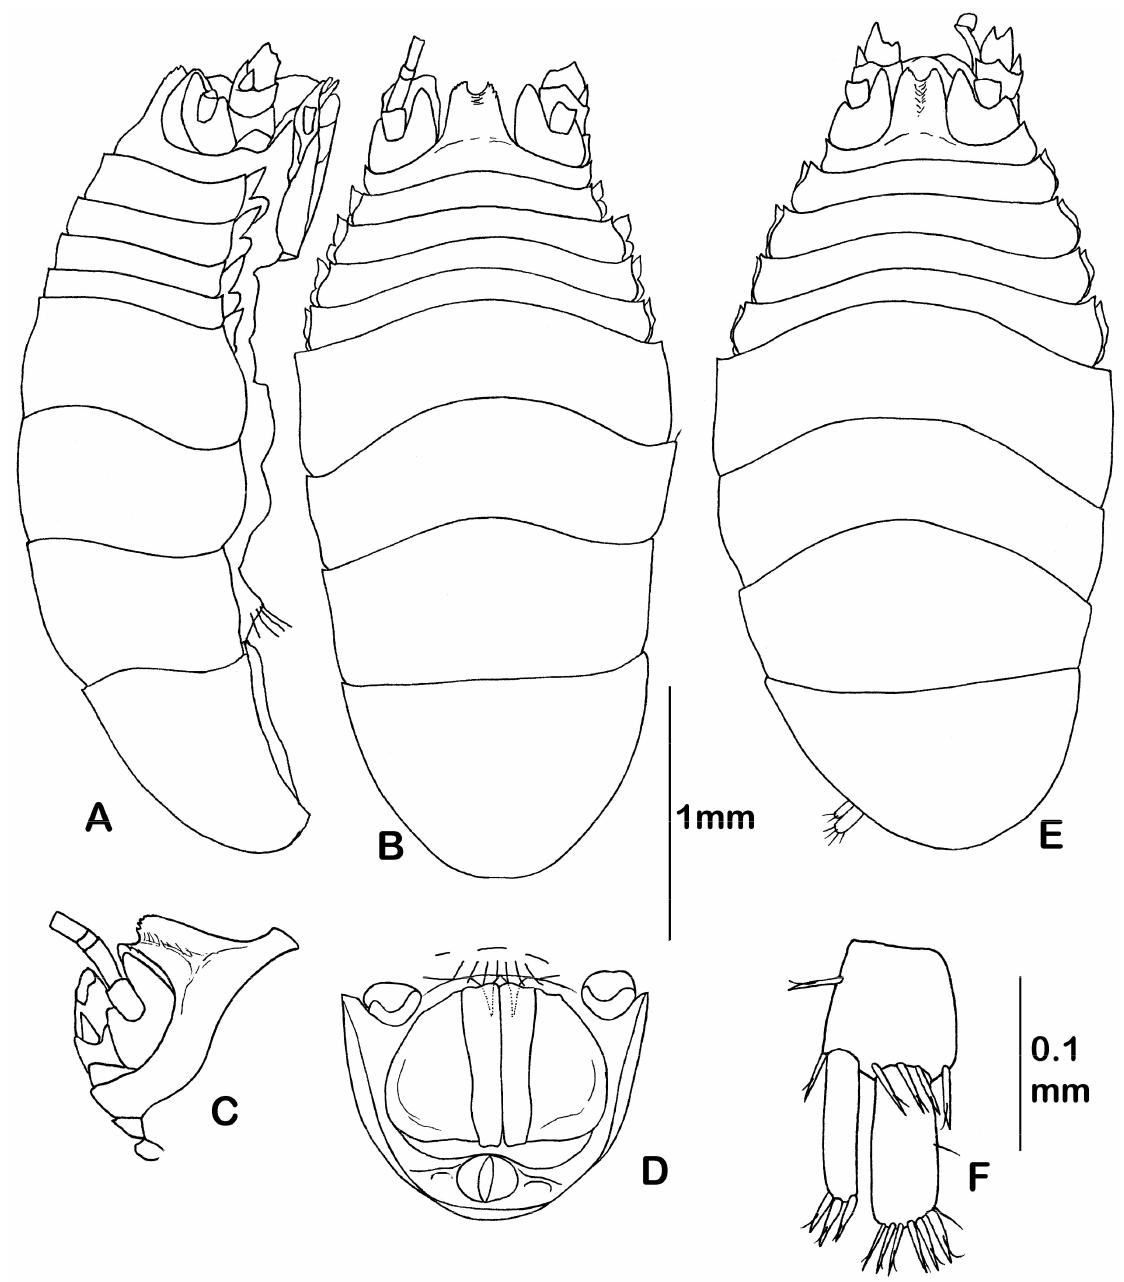
Figure 14. Eurycope mishkai sp. nov. Male holotype (ZMH K-45621): ( A ) lateral view; ( B ) dorsal view; ( C ) cephalon with rostrum, antenna I and antenna II; ( D ) pleotelson, ventral view. Female paratype (ZMH K-45626): ( E ) dorsal view. Female paratype (ZMH K-45625): ( F ) uropod. Pereopods broken off. Pleopod I (male paratype, ZMH K-45624, Figure 16A) length 2.5 times basal